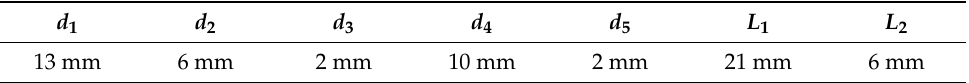
Table 1. Parameters of the basic